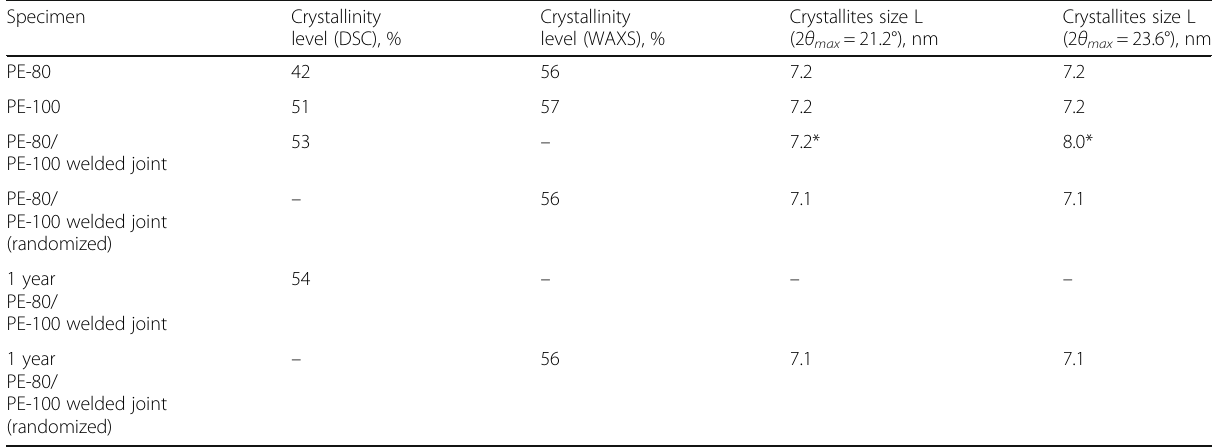
Table 1 Structural characteristics of PE-80 and PE-100 polyethylene and of PE-80/PE-100 welded joint Specimen Crystallinity level (DSC),